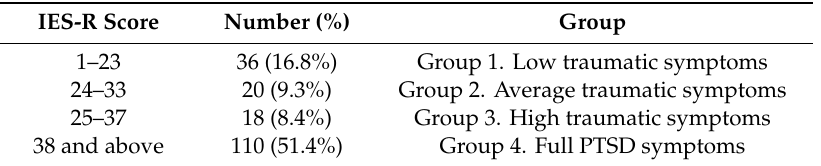
Table 1. Prevalence of traumatic symptoms.